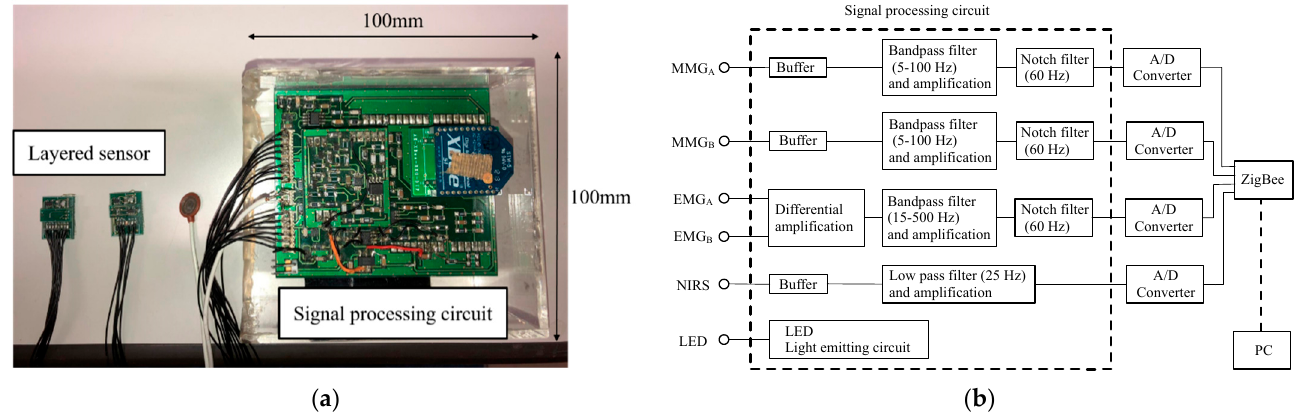
Figure 3. Wireless multi-layered sensor: ( a ) photograph of the device and ( b ) schematic diagram of the signal processing system.